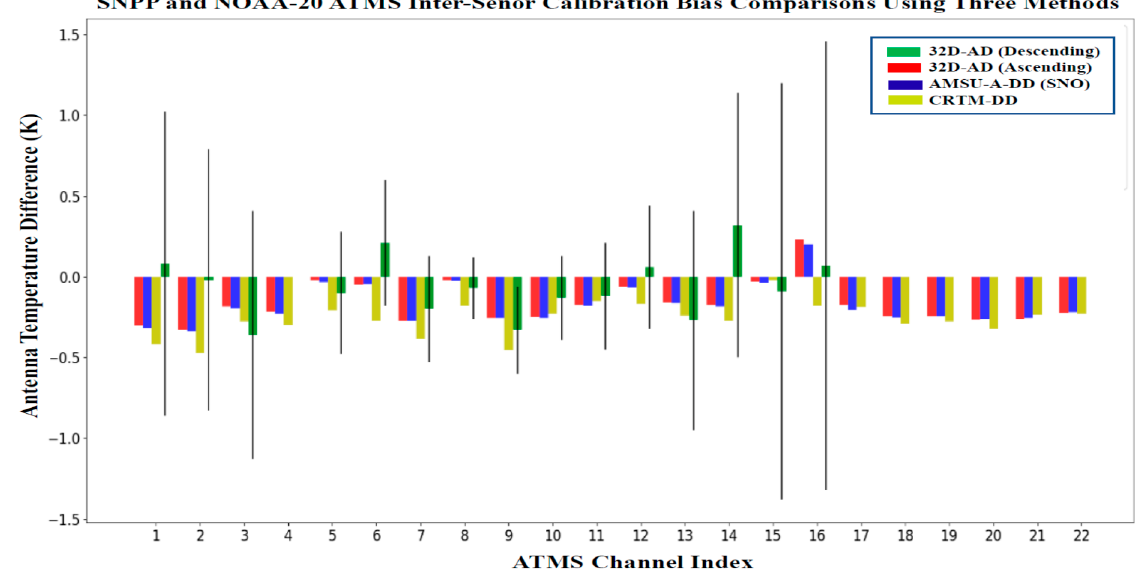
Figure 8. SNPP and NOAA-20 ATMS inter-sensor calibration radiometric biases at 22 channels using the 32D-AD method, where the data span from 1 November 2020, to 2 December 2020, and 32D-AD datasets are generated in ascending and descending, respectively. The figure also includes the inter-sensor biases at the part of ATMS channels that are calculated using the CRTM-DD and AMSU-A-DD methods. The CRTM-DD represents the double-differences of SNPP and NOAA-20 ATMS Scheme 20. ATMS SDR data via the Metop-C AMSU-A as a transfer. The AMSU-A-DD results are an average of all SNO cases passing the QC with 1 standard deviation between AMSU-A and ATMS from January 1 to December 31, 2020. The CRTM-DD results are an average of the results from December 1, to December 31, 2020.